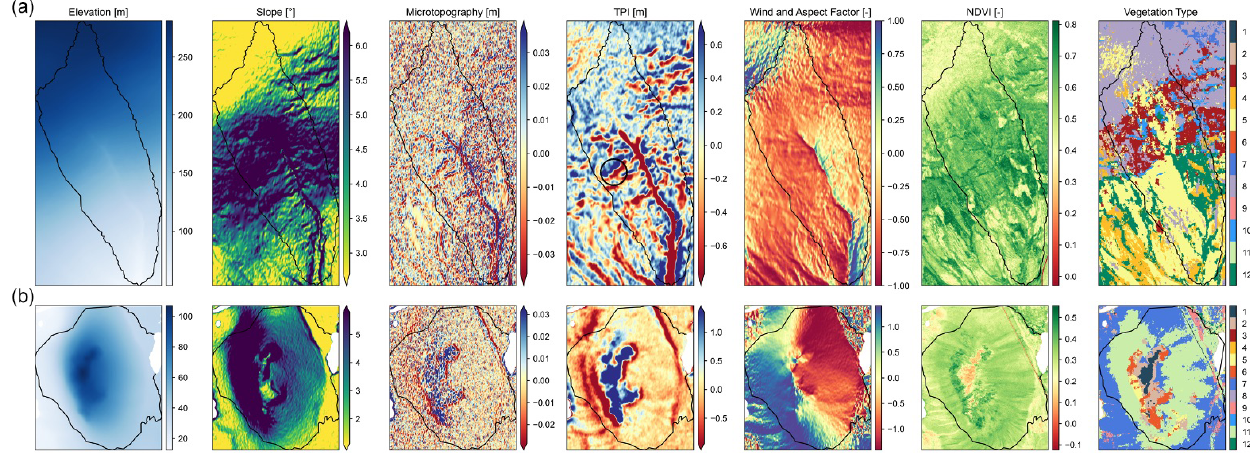
Figure 4. Input features included in the snow models (elevation, slope, microtopography, TPI, wind and aspect factor, and NDVI and vegetation type) for (a) Teller and (b) Kougarok Hillslope. The white areas shown in the Kougarok Hillslope maps are lakes. An open circle on the TPI figure denotes one of the terraces and riser. The vegetation types are (1) Dryas–lichen dwarf shrub tundra, (2) birch–Ericaceous– (7) tussock–lichen tundra, (8) wet meadow tundra, (9) wet sedge bog–meadow, (10) mesic graminoid–herb meadow tundra, (11)